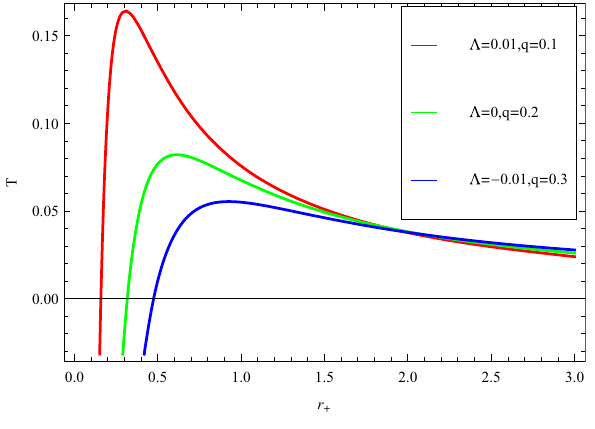
Fig. 7 Plot of T versus r + 3 RBH with Cosmological Constant